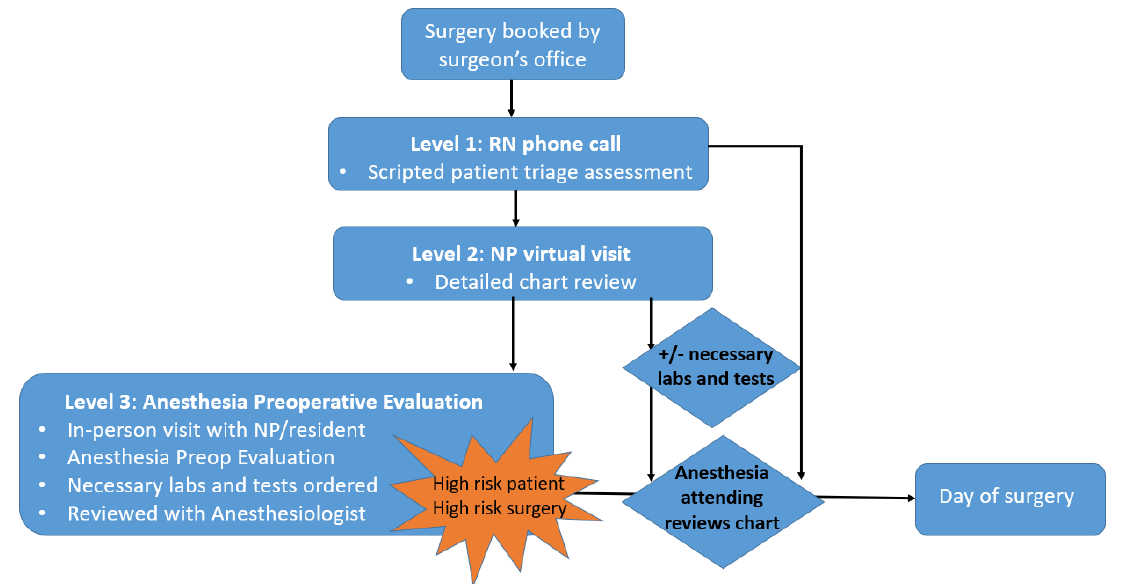
Figure 1. Preoperative evaluation center flowchart. The process starts with the surgeon scheduling the surgery. Level 1: the registered nurse (RN) calls the patient. The next phase of care is determined by a triage algorithm (Appendix B) and can include: (1) no further work-up needed, (2) additional preoperative testing, which could be arranged at a location convenient to the patient, (3) a chart review conducted by a nurse practitioner (NP), (4) an in-person visit to the PEC. All charts are reviewed by the anesthesiologist on the day before